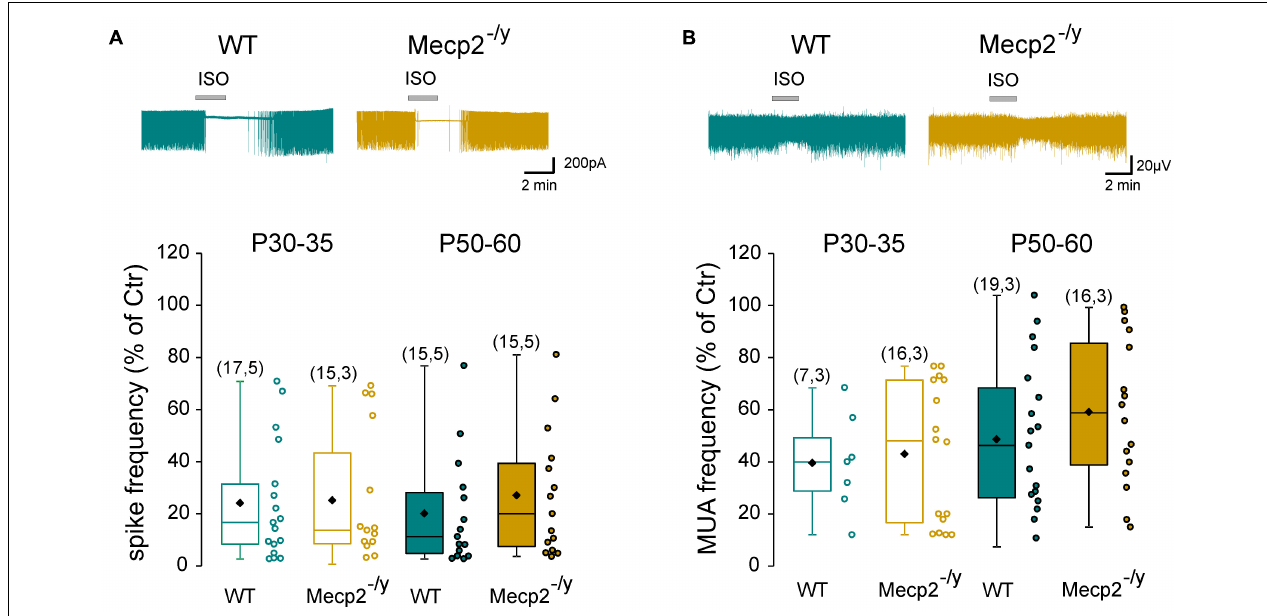
FIGURE 4 | Strength of GABAergic inhibition onto wild-type and Mecp2 - / y CA3 hippocampal pyramidal neurons. Top traces: loose patch recordings (A) and field recordings (B) of CA3 pyramidal neurons on acute hippocampal slice from a P50 WT and Mecp2 - / y mouse. Box plots of isoguvacine effects normalized to the baseline spike frequency (A) or multi-unit activity (MUA) (B) in P30–35 and P50–60 WT and Mecp2 - / y